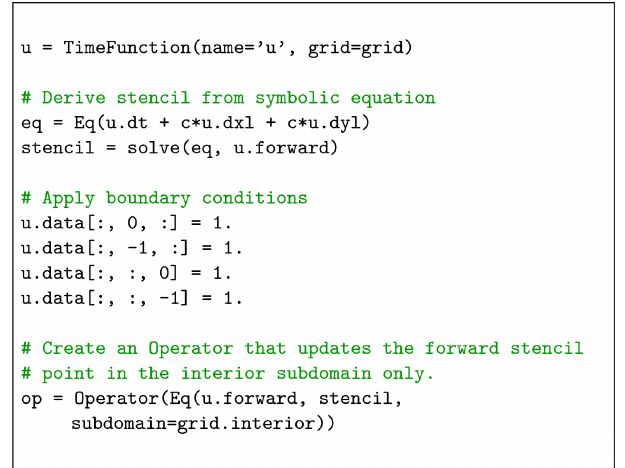
Figure 14. Convection equation in Devito. In this example, the initial Dirichlet boundary conditions are set to 1 using the API indexing feature, which allows us to assign values to the TensorFunction